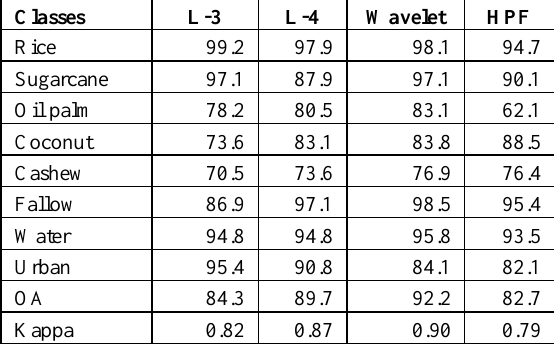
Table-4: Classification accuracy of different fusion